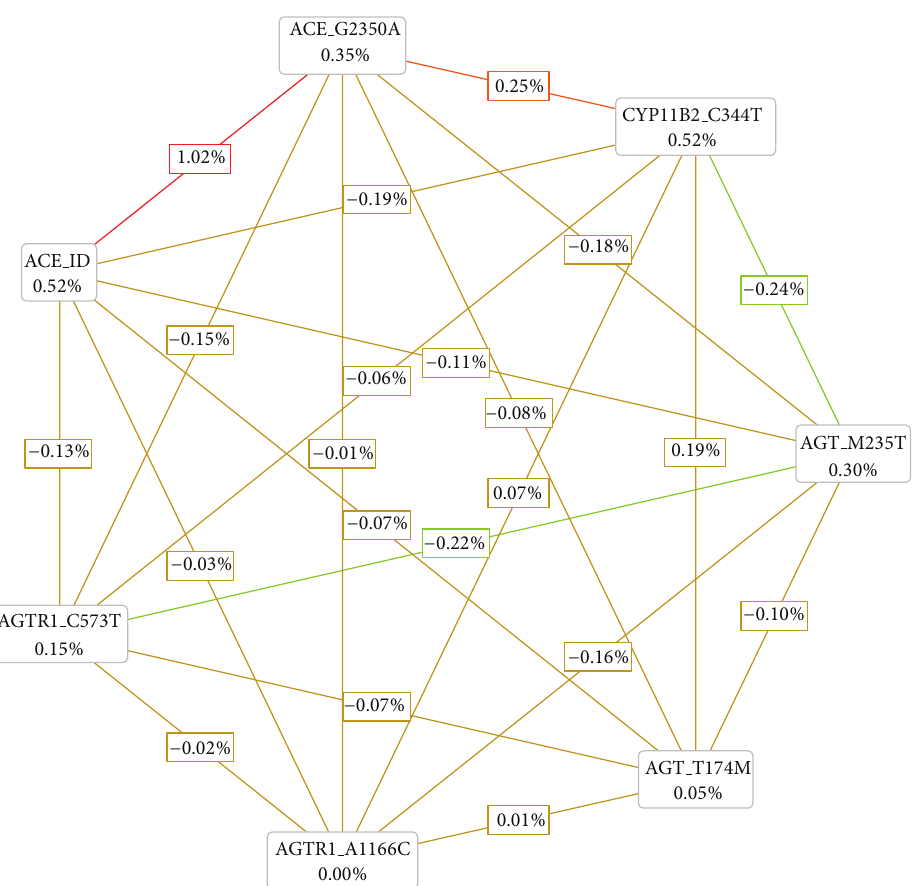
Figure 2: Interaction map for ESRD risk. The values inside boxes indicate information gain (IG) of individual attribute or main effects, whereas values between nodes exemplify IG of pairwise combinations of attributes or interaction effects. A positive entropy (plotted in red or orange) indicates interaction while a negative (plotted in green) indicates redundancy.